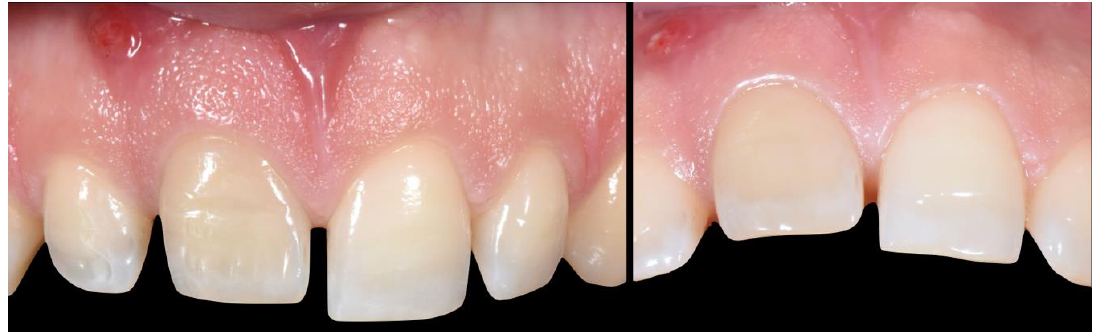
Figure 3. Pre-operative clinical conditions; buccal dislocation of tooth #1.1 is evident.